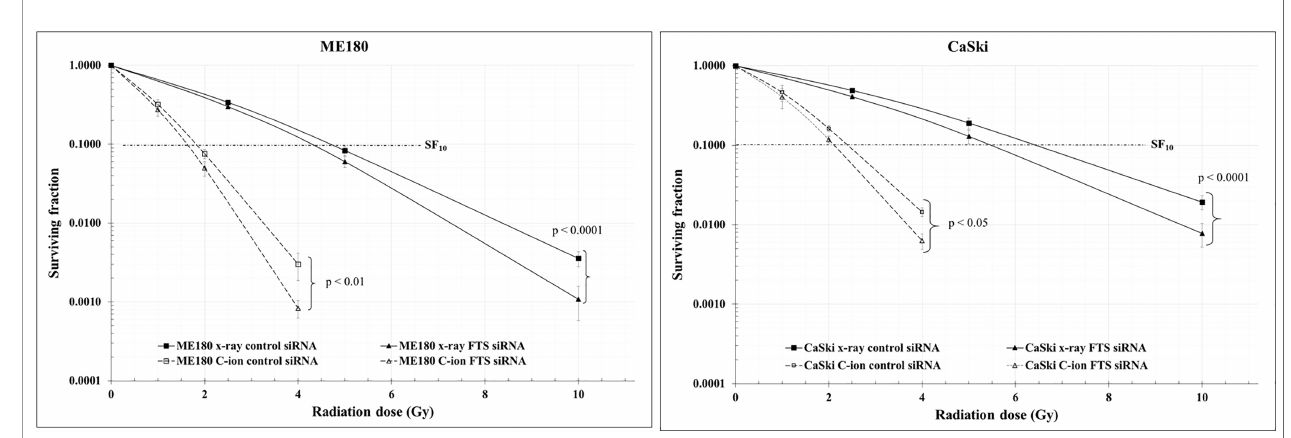
FIGURE 6 | Clonogenic cell survival was reduced by the combination of radiation with FTS silencing. Cells treated with scrambled siRNA or FTS siRNA were irradiated with C-ion (0, 1, 2 and 4 Gy) or x-rays (0, 2.5, 5 and 10 Gy). Following irradiation, the cells were trypsinized, harvested and seeded in triplicates, in appropriate cell densities in 60 mm dishes. The cells were allowed to grow for 7-8 days. Colonies with 50 or more cells were considered as survivors. The survival curves represent the mean of three independent experiments ±